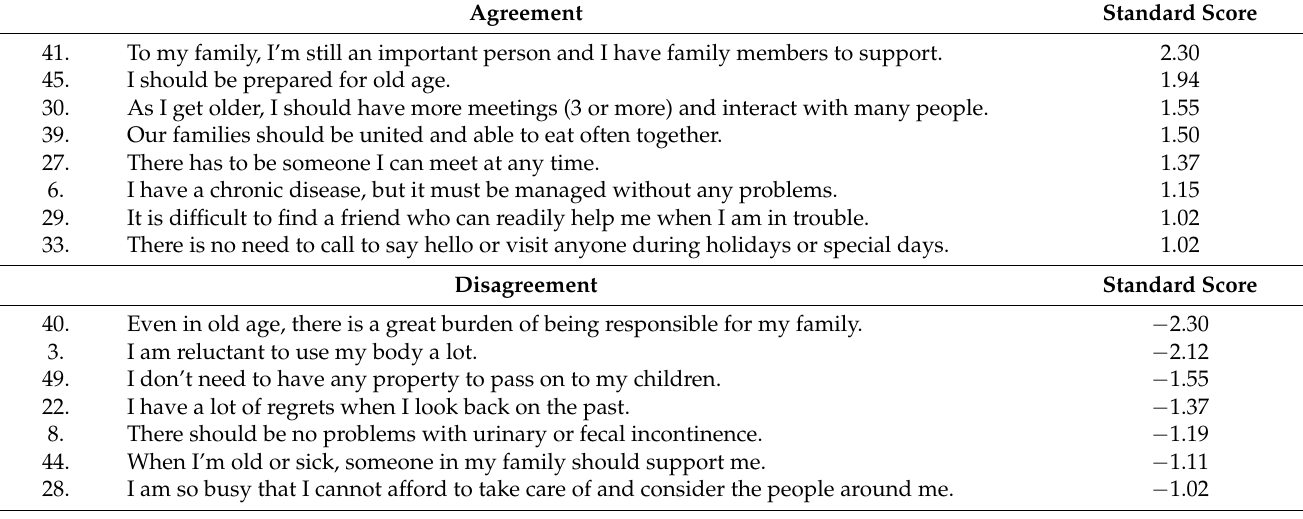
Table 9. The Q-statements with strong agreement or disagreement by Type